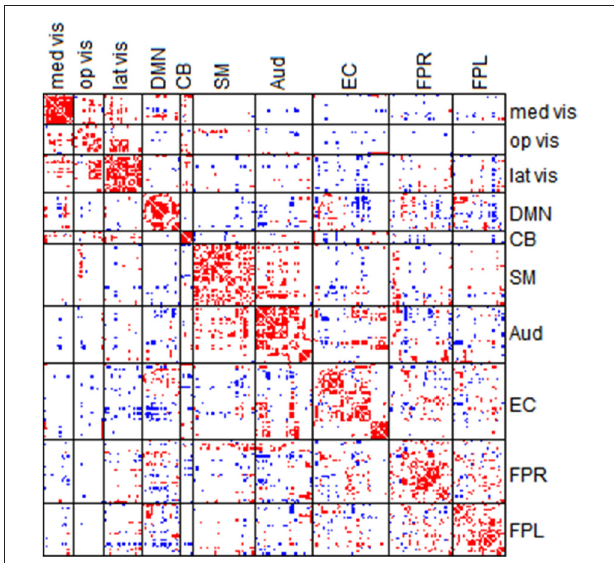
FIGURE 10 | Edges in category C. Category C contains the significant edges in both partial correlation and full correlation (absolute effect size > 0.5); Red denotes positive edges and blue denotes negative edges.